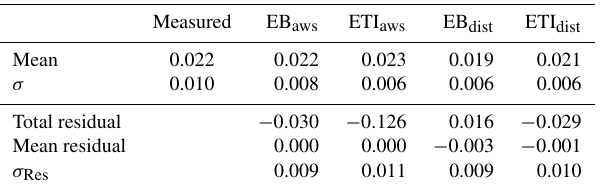
Table 2. Descriptive statistics for measured melt, modelled melt, Table 3. Robust correlation statistics ( R r ) for surface characteristics and model residuals at the AWS site from 14 to 31 July 2016. All and distributed models. Strong correlations are highlighted in bold. values were calculated based on 12h melt estimates and are reported in metres. We denote the standard deviation of all 12h melt values EB dist ETI dist with σ and the standard deviation of all residuals in 12h model Albedo − 0 . 207 − 0 . 208 estimates with σ Res . Aspect 0.177 0.178 Slope 0.204 0.197 Measured EB aws ETI aws EB dist ETI dist 0.470 Mean 0.022 0.022 0.023 0.019 0.021 σ 0.010 0.008 0.006 0.006 0.006 − 0 . 030 − 0 . 126 0.016 − 0 . 029 0.000 0.000 − 0 . 003 0.009 0.011